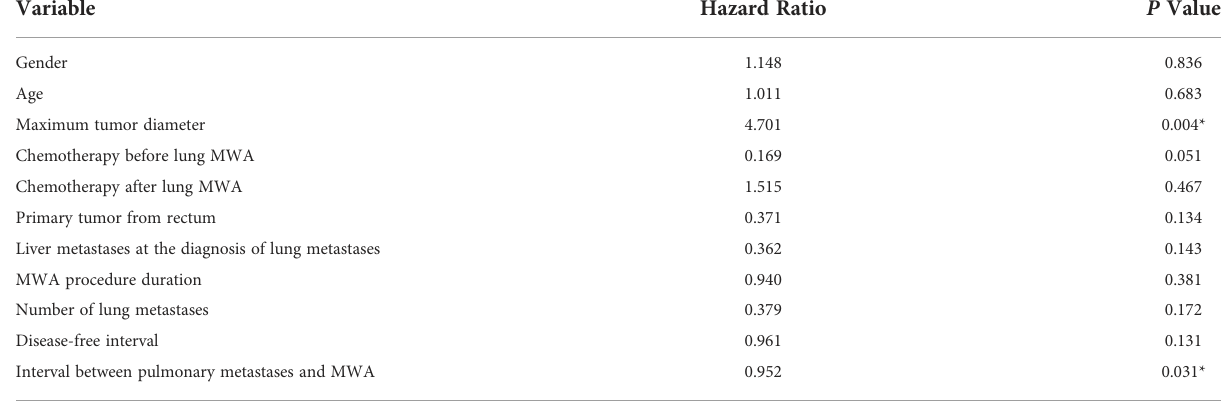
TABLE 4 Multivariable analyses of prognostic factors for progression-free survival. Variable Hazard